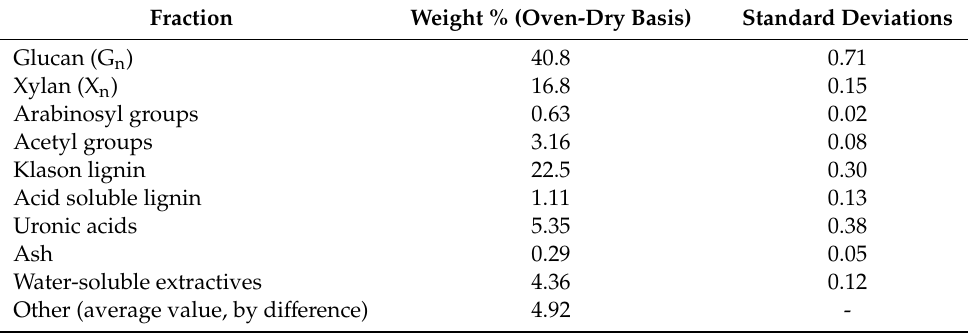
Table 1. Composition of the E. globulus wood lot employed in experiments (data obtained from triplicate